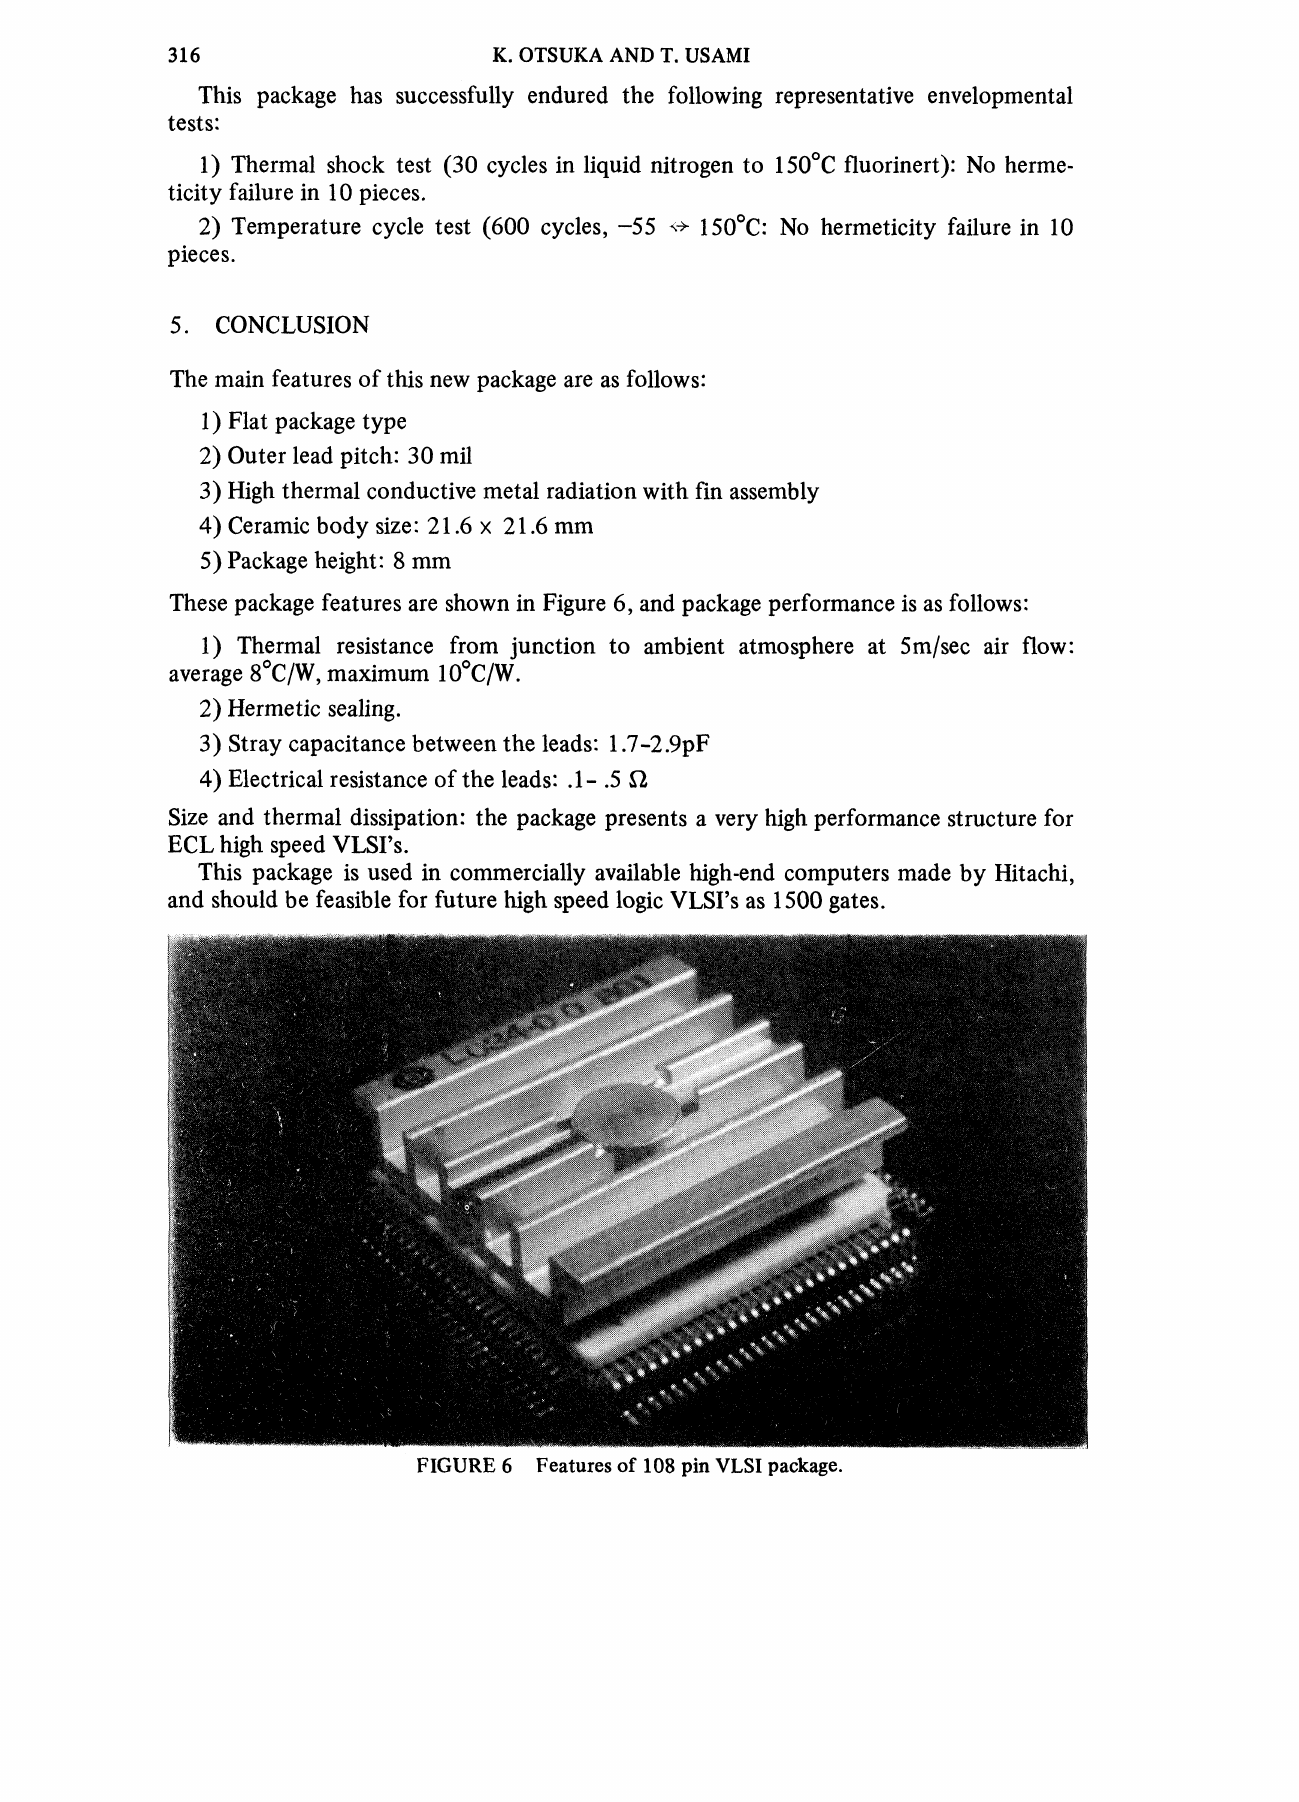
FIGURE 6 Features of 108 pin VLSI